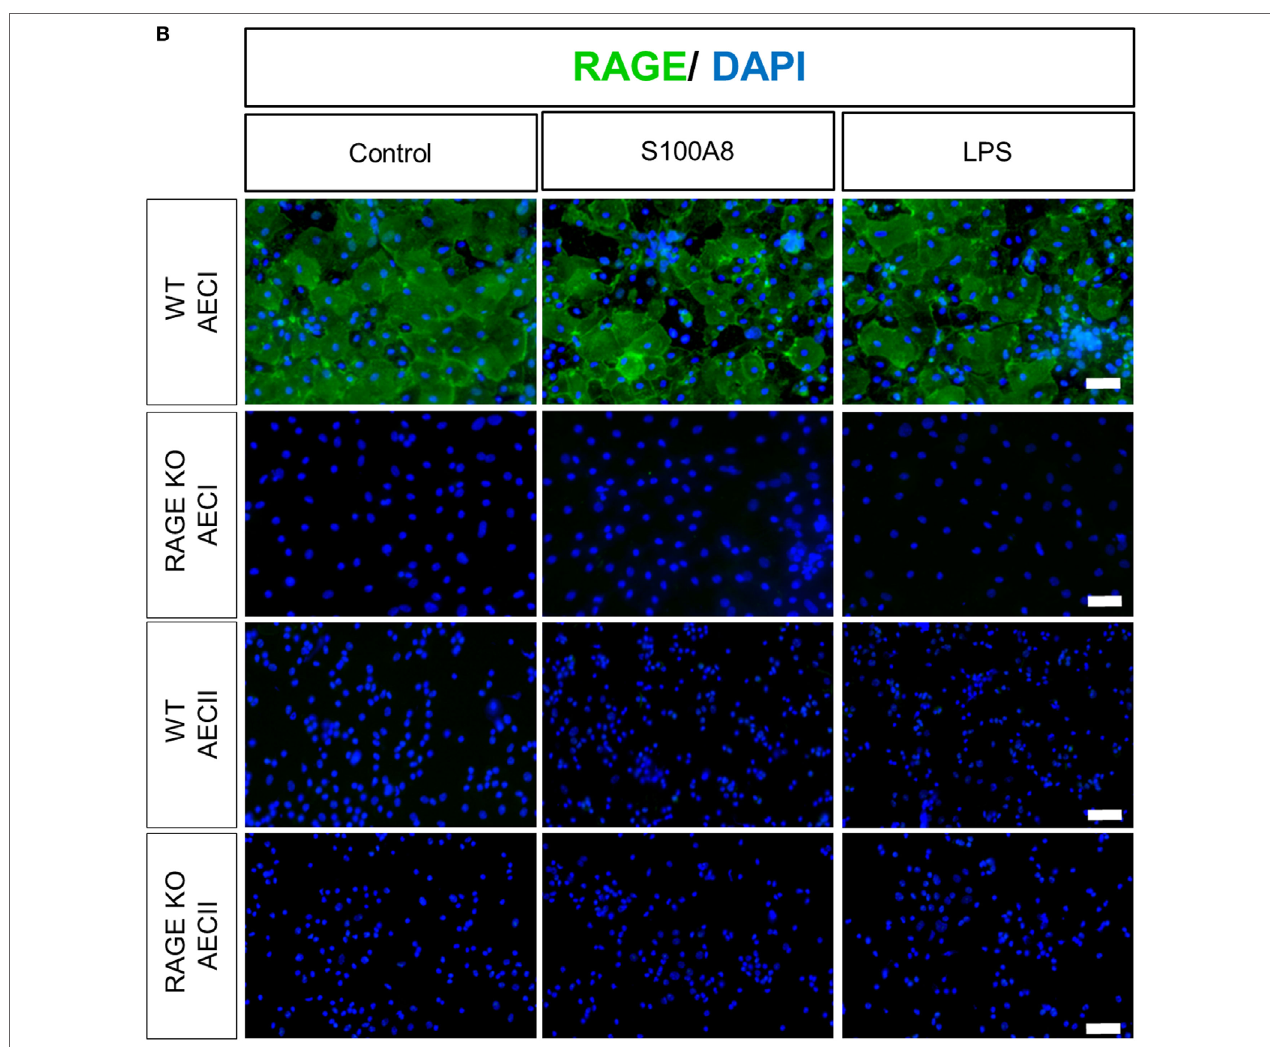
FigUre 4 | TLR4-MD-2 and RAGE expression in isolated alveolar epithelial cells (AECs). WT, TLR4 knock out (TLR4 KO), and RAGE knock out (RAGE KO) AECII and AECI were cultured for 1 or 7 days, respectively, and then stimulated by murine S100A8 (5 µg ml − 1 ) or lipopolysaccharide (LPS) (10 ng ml − 1 ) for 6 h. (a) WT and TLR4 KO AECI and AECII were stained for TLR4-MD-2 (Streptavidin Dylight 488) (B) WT and RAGE KO AECI and AECII were stained for RAGE (goat anti rabbit Alexa Fluor 488). Nuclei were stained with DAPI. Imaging was performed by an inverted fluorescent microscope (Axio Observer, Zeiss), n = 3 experiments for (a,B) and representative images are shown. Scale bars are 50